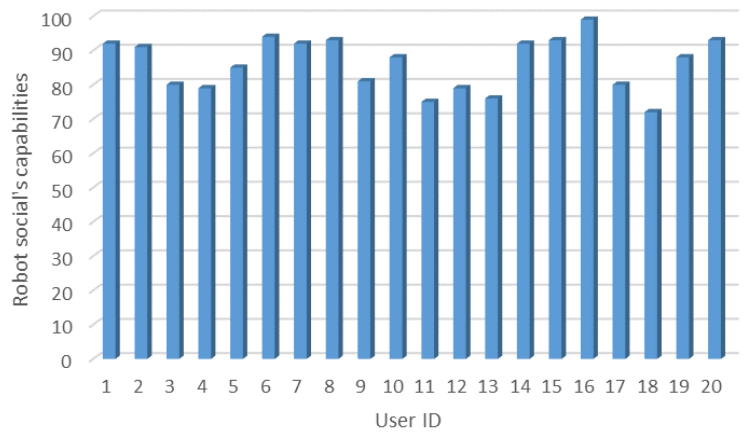
Figure 16. Assessment of the robot social’s capabilities.